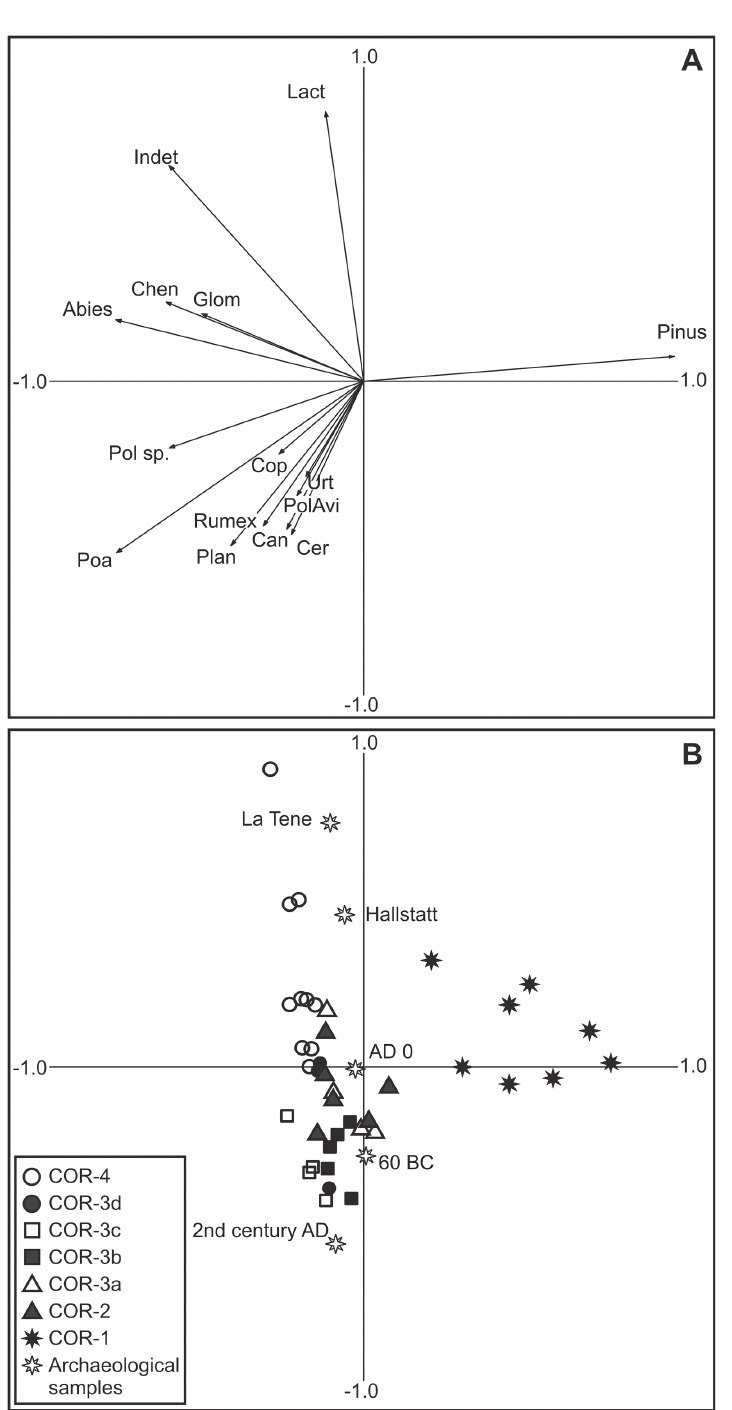
Fig 3. PCA plots for the profile. A. Pollen types and associated proxies (selected taxa only). B. Sample scores for pollen and spore dataset with archaeological samples included as passive samples. Key to abbreviations: Can = Cannabis/Humulus; Cer = Cerastium -type; Chen = Chenopodiaceae; Cop = coprophilous fungi; Glom = Glomus ; Indet = Indeterminable pollen; Lact = Lactuceae; Plan = Plantago sp.; Poa = Poaceae; PolAvi = Polygonum aviculare -type; Pol sp. = Polygonum sp.; Urt = Urticaceae.